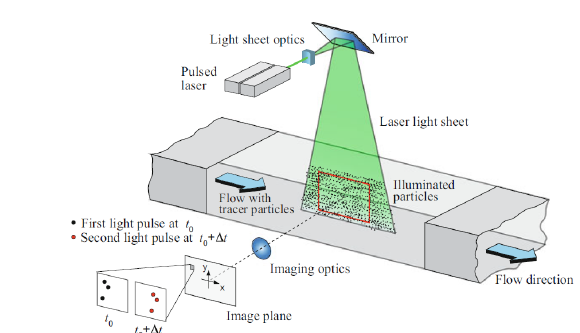
Figure 1. Exemplary representation of PIV (Raffel et al., 2018, p.8)